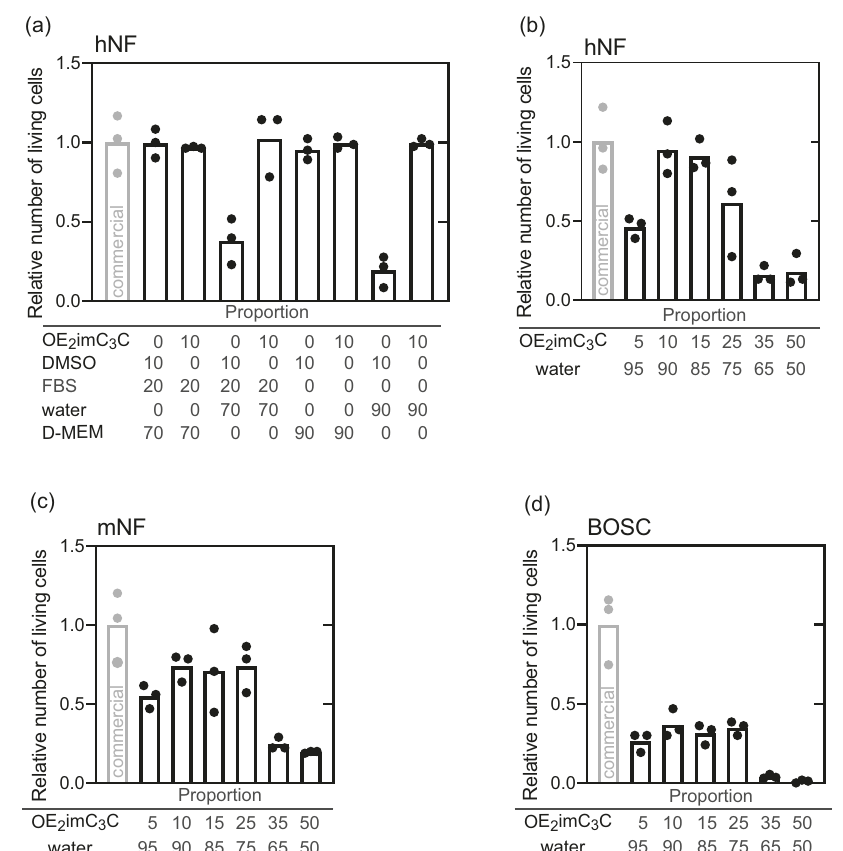
Fig. 2 Cryopreservation using OE 2 imC 3 C-based freezing media. Relative number of living a , b hNF, c mNF, and d BOSC cells after cryopreservation with the indicated freezing media ( n = 3, experimentally triplicate). In this experiment, DMSO was measured in volume. The commercial cryoprotectant employed was Culture Sure freezing medium (Fuji fi lm Wako Pure Chemical